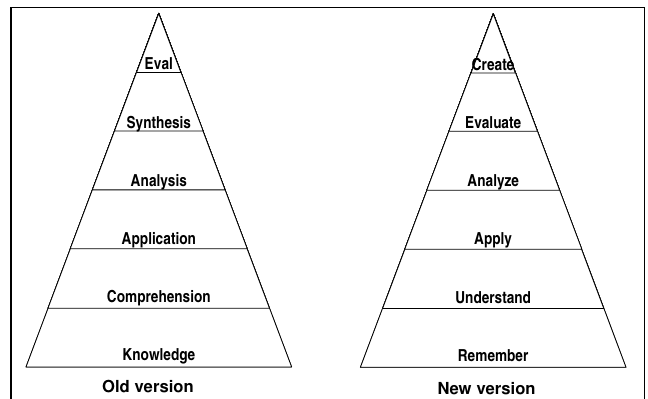
Fig. 5. Bloom’s taxonomy of learning in the knowledge domain.